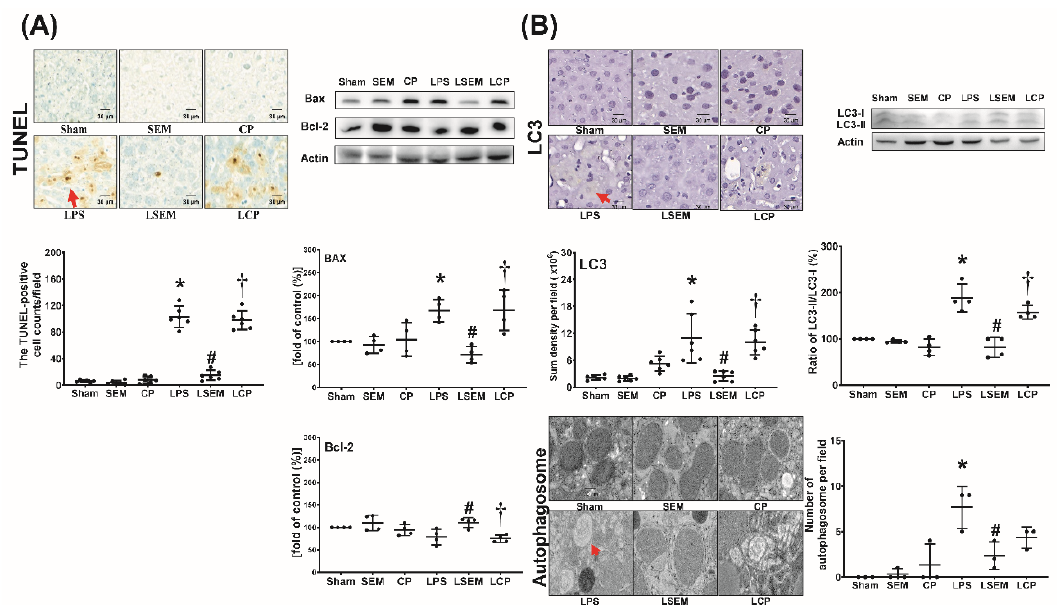
Figure 6. SEM18 peptide mitigates endotoxin-induced ( A ) apoptosis and ( B ) autophagy upregulation in the liver, as measured at 24 h after lipopolysaccharide (LPS) or normal saline (NS) administration. ( A ) Representative microscopic images of DNA fragmentation (red arrow) in liver tissues (200 × ) assayed using terminal deoxynucleotidyl transferase dUTP nick-end labeling (TUNEL) method and mean TUNEL-positive cell counts (per 0.25 mm 2 ). Representative gel photography of apoptosis-related proteins (i.e., the proapoptotic Bax and the antiapoptotic Bcl-2) and actin (the internal standard) in liver tissues assayed using immunoblotting assay and the band densities of Bax / actin and Bcl-2 / actin. ( B ) Representative microscopic images of microtubule-associated protein 1A / 1B-light chain 3 (LC3, red arrow) in liver tissues (200 × ) measured using immunohistochemistry assay and the quantitative sum intensity of LC3. Representative gel photography of LC3-I, LC3-II, and actin (the internal standard) in liver tissues and LC3-II / LC3-I ratio. Representative transmission electron microscopic images of autophagosome (red arrow) in liver tissues (6000 × ) and the mean autophagosome numbers (per 2 µ m 2 ). Sham: the NS group; SEM: the NS plus SEM18 peptide group; CP: the NS plus control peptide (CP) group; LPS: the lipopolysaccharide (15 mg / kg) group; LSEM: the LPS (15 mg / kg) plus SEM18 peptide group; LCP: the LPS (15 mg / kg) plus CP group. Data are the mean ± standard deviation. Data of immunohistochemistry staining assay, immunoblotting assay, and transmission electron microscopic were derived from five, four, and three mice from each group, respectively. * p < 0.05, the LPS group vs. the sham group; # p < 0.05, the LSEM group vs. the LPS group; † p < 0.05, the LCP group vs. the LSEM group.